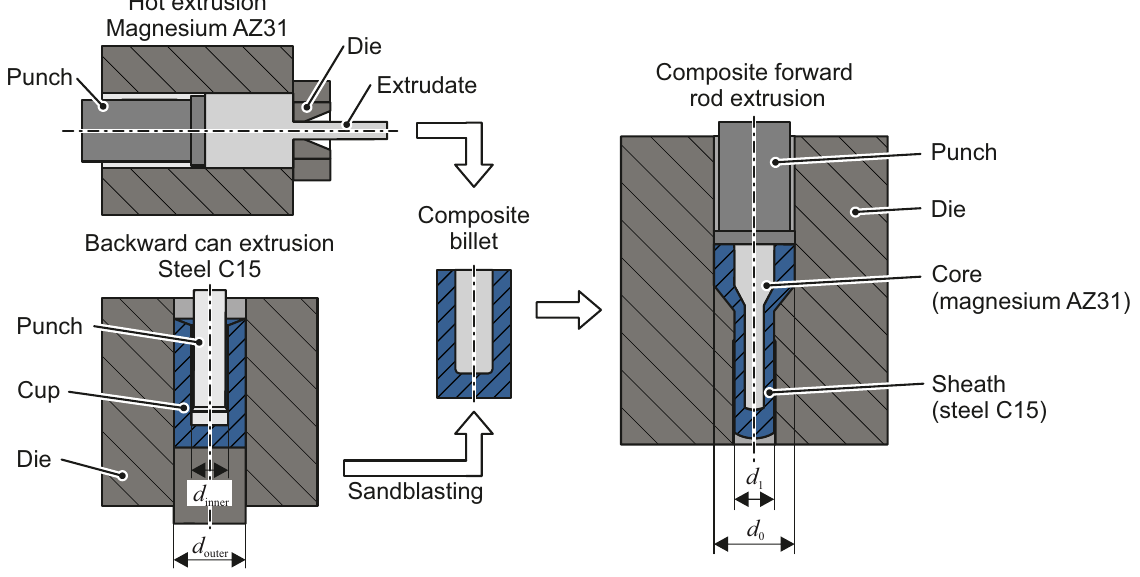
Figure 4. Process route for production of composite shafts with magnesium core. The composite core, consisting of a backward can extruded steel cup and a hot extruded magnesium core is formed to a shaft by composite forward rod